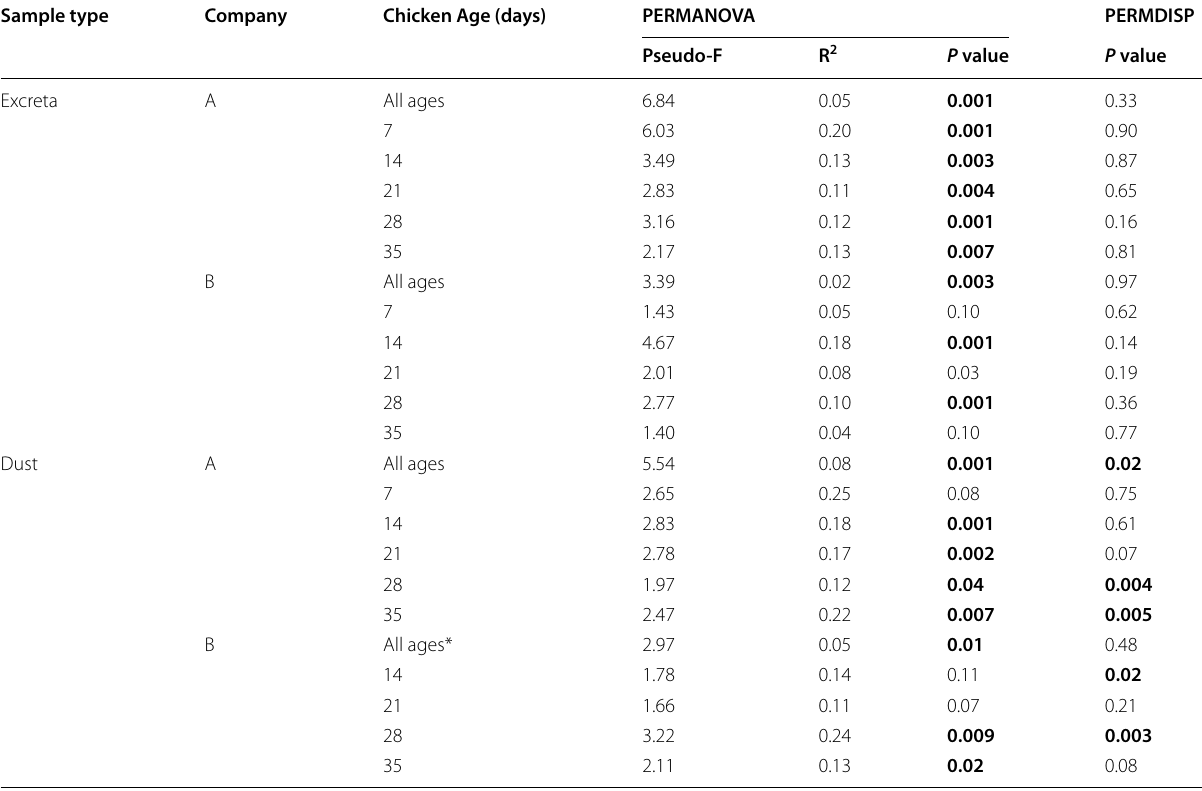
PERMDISP, permutational analyses of multivariate dispersions * Dust samples collected on day 7 from company B were excluded due to the small sample Values in bold indicate statistical significance ( p <